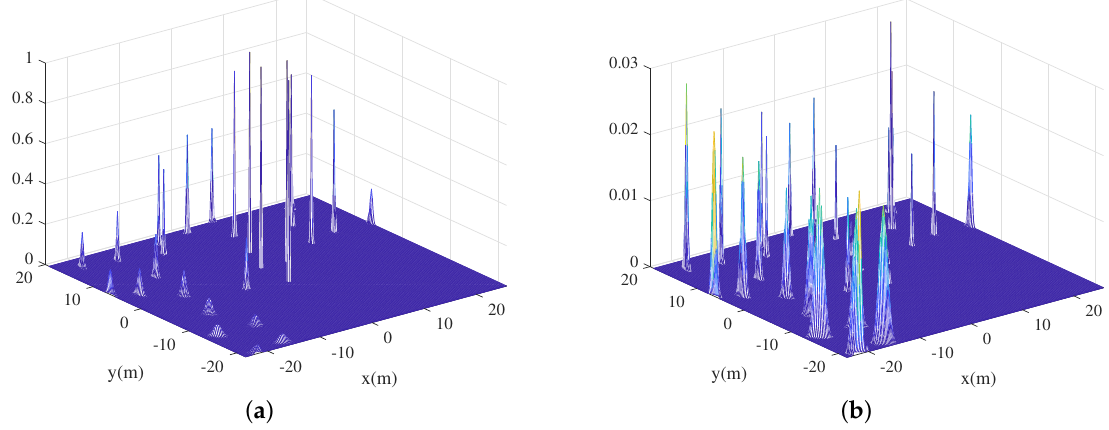
Figure 2. The distribution of each landmark on the gridmap: ( a ) The Gaussian distribution of each landmark. ( b ) The Gaussian distribution multiplied by the trace value of each landmark.